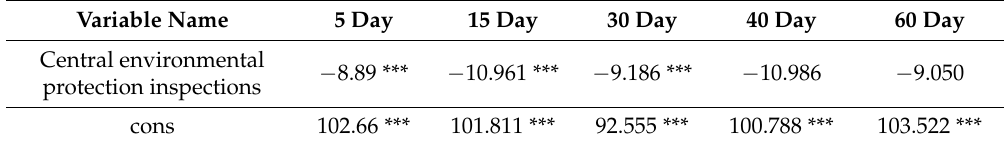
Table 3. Regression results for multiple periods after the